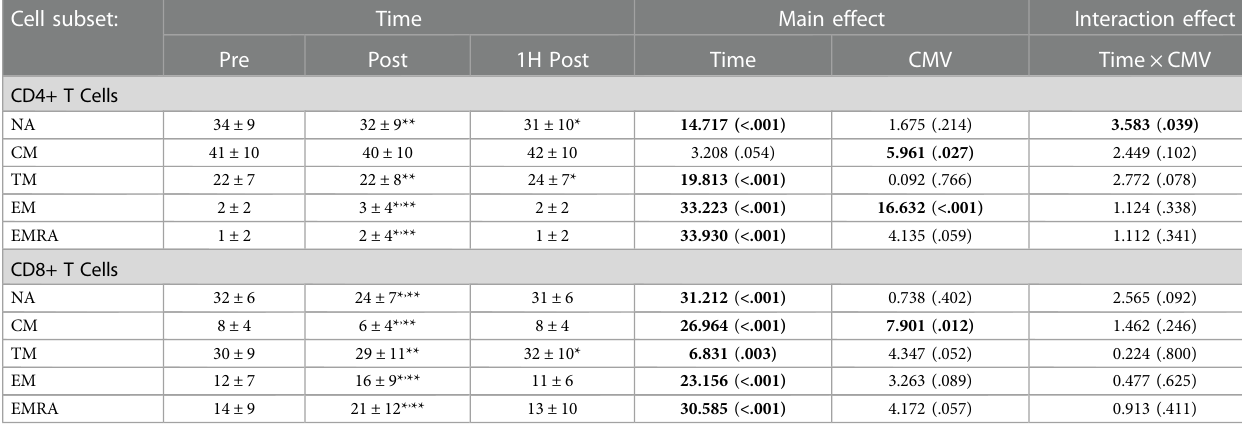
TABLE 4 The proportions of CD4+and CD8+ T-cell subsets in peripheral blood Pre-, post-, and 1H post-exercise. Values are means±S.D.; Main and interaction effects are F-statistic ( p -value). Cell